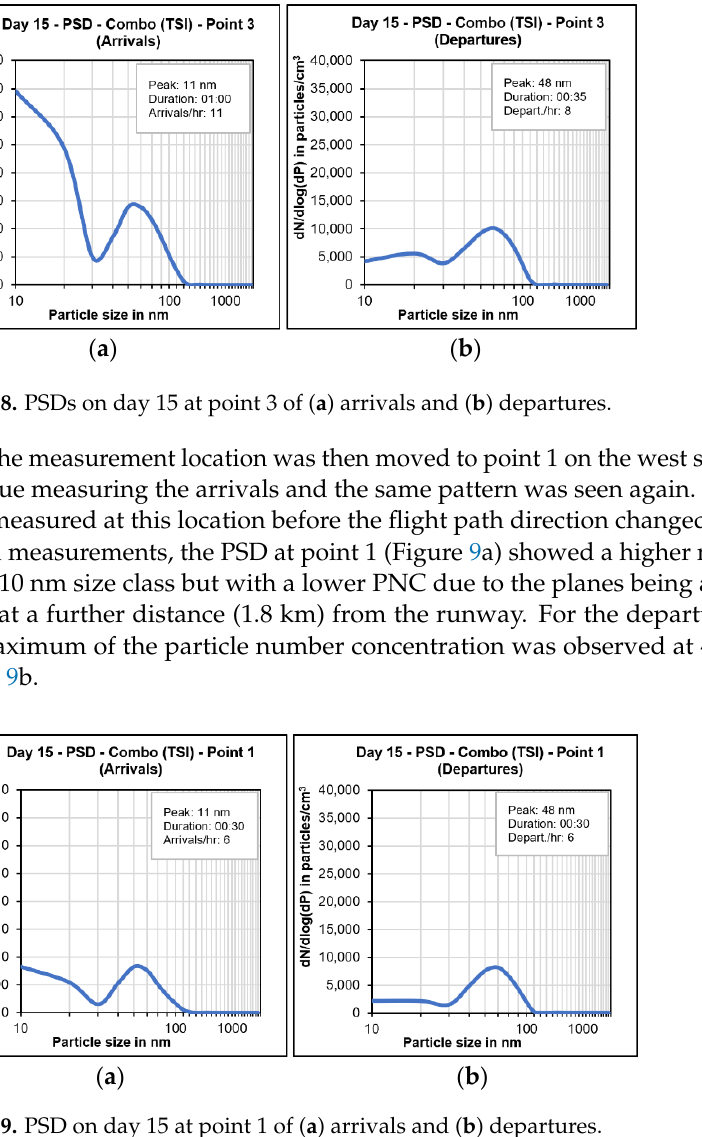
Figure 7. Daily average PSDs on ( a ) day 11, ( b ) day 12, ( c ) day 13, ( d ) day 14 (phase 3).